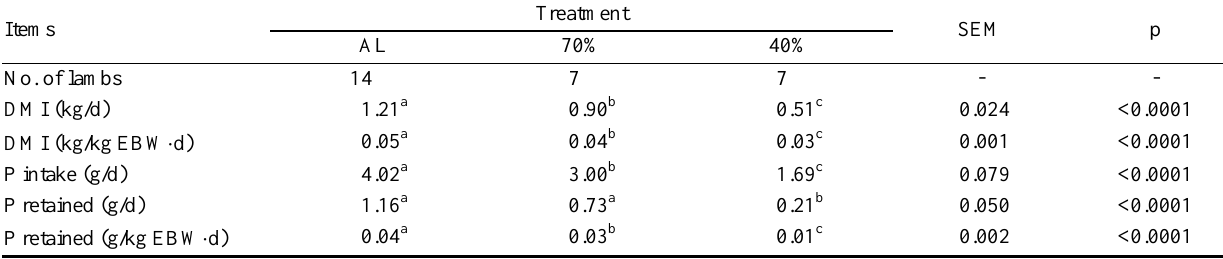
a,b,c In the same row, different superscript letters indicate significant differences (p<0.05). d DMI = Dry matter intake, EBW = Empty body weight, ADG = Average daily gain, AL = Ad libitum , 70% = Restricted to 70% of ad libitum , 40% =